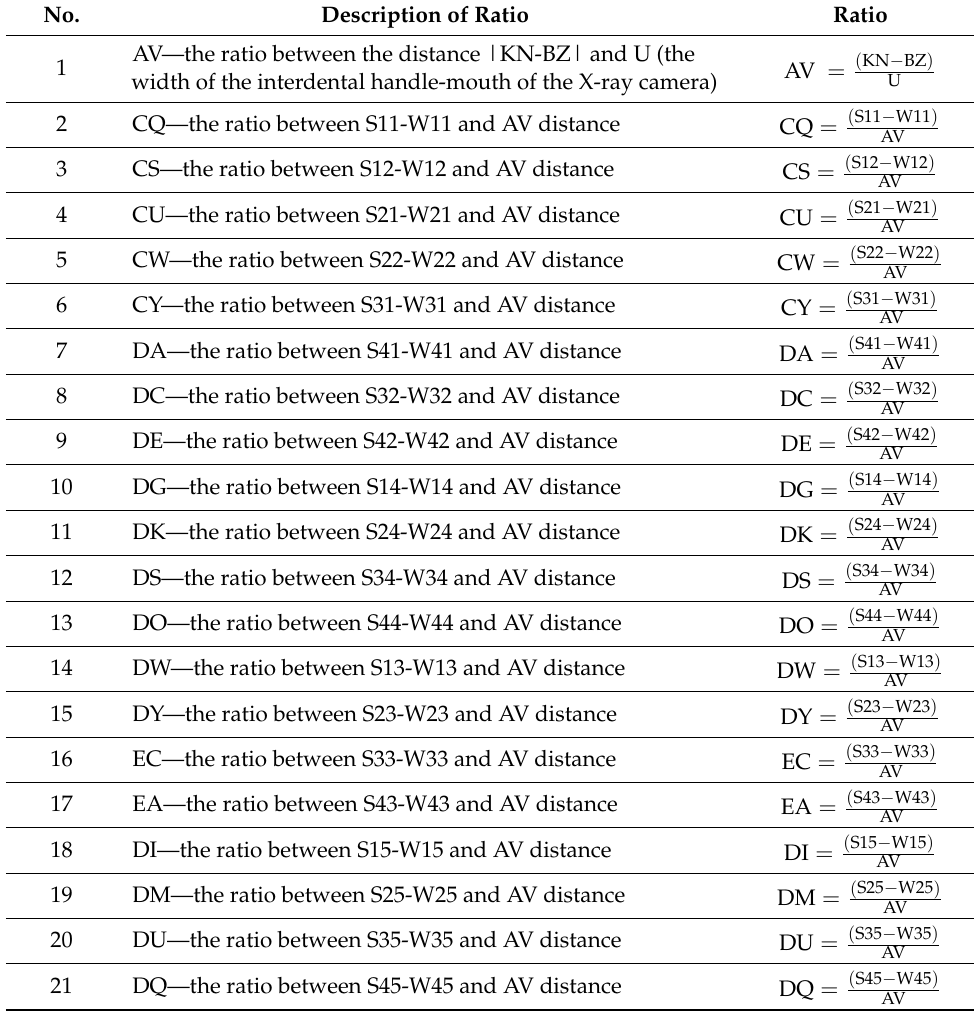
Table 1. Indicators in the form of mathematical proportions. No. Description of Ratio